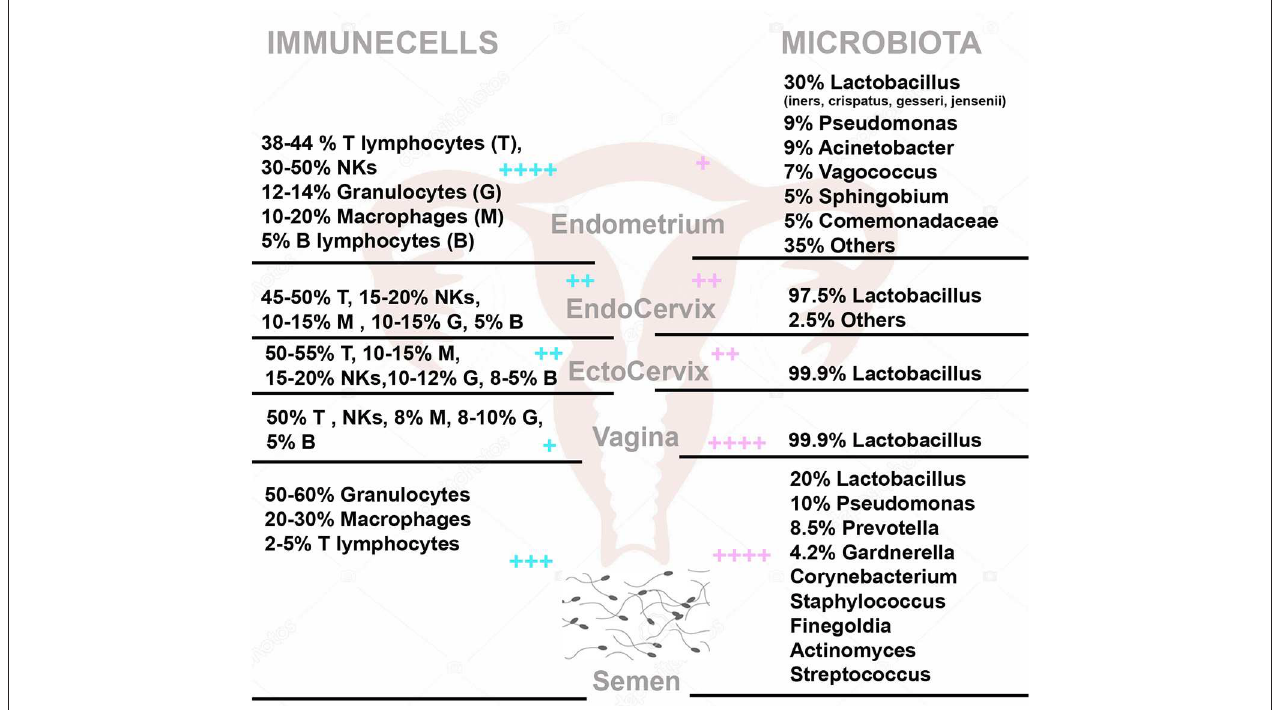
FIGURE 2 | The immune cells (Left) and microbiota (Right) within the female genital tract and semen. On the left side are the percentage with (respect to total CD45 positive cells) of T Lymphocytes (T), NK cells (NKs), Granulocytes (G), Macrophages (M), and B Lymphocytes (B) in Endometrium, Endocervix, Ectocervix, Vagina and semen. On the right side, is shown the median relative abundance of microbial genera. + + ++ / + represent the relative abundance amount of microorganisms and immune cells in different